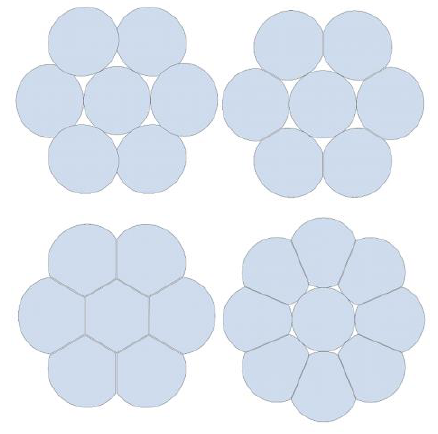
Fig. 3. Possible FAST mirror segmentation.